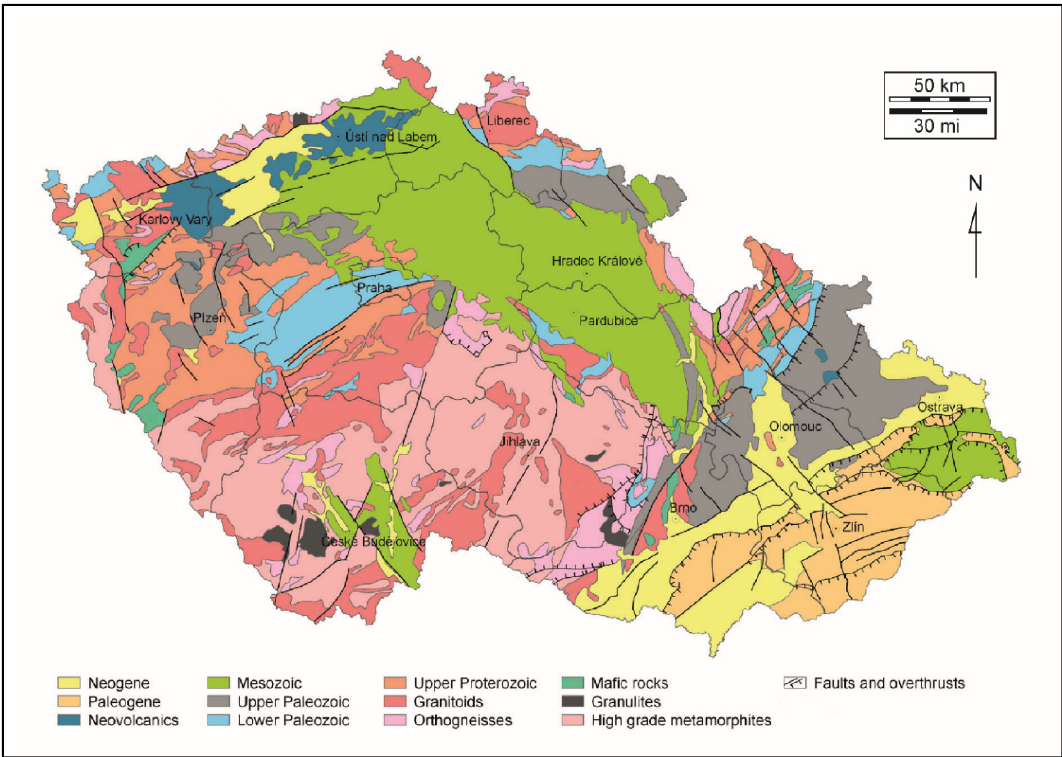
Figure 2. Simplified geological map the Czech Republic [38].